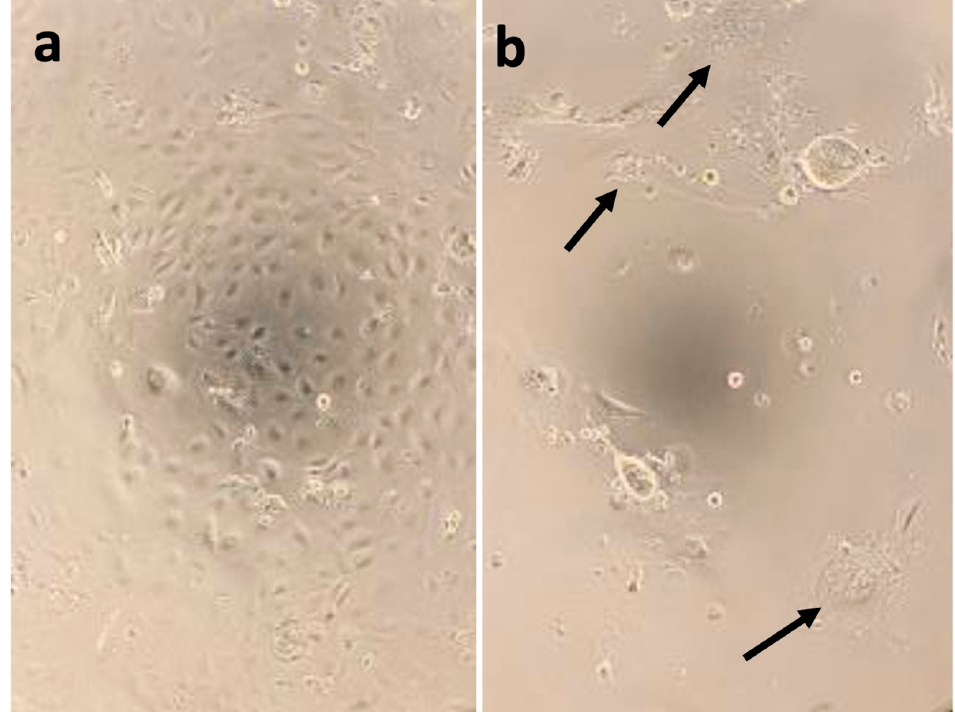
Figure 3. ( a ) A normal monolayer of white sturgeon × lake sturgeon (WSxLS) cells and ( b ) WSxLS cells showing cytopathic effects less than 14 days post-infection (15 °C) with tissue infected with virus. Arrows indicate large, multinucleated giant cells, or syncytia.